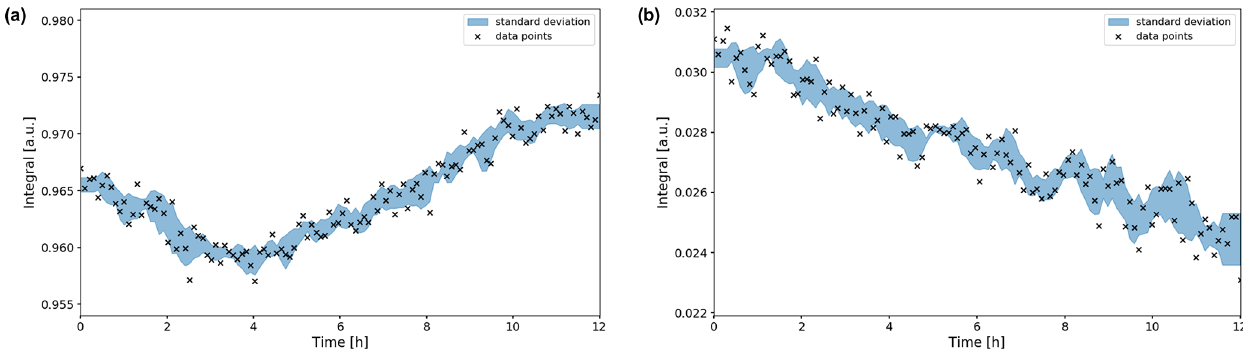
− (a) and CO 2 (b) signal integrals during the OCV stage. The integrals were normalized to their Figure 9. Time evolution of the HCO 3 maximum values during the in operando experiment. Error boundaries are shown in blue. The HCO − while the CO 2 signal decreases significantly in intensity over the 12h period, down to 78% of its maximum